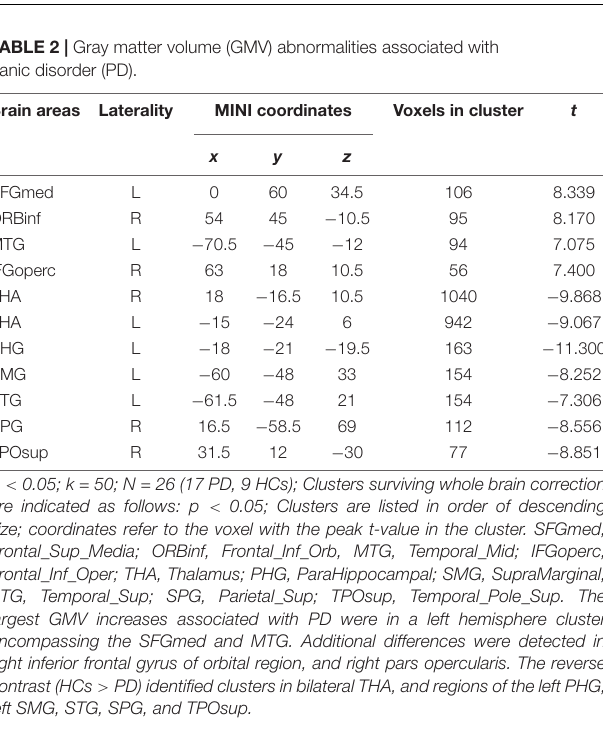
FIGURE 2 | Correlation between PDSS and GAD1 cg 12 methylation. Higher PDSSSUM scores were associated with relatively decreased cg171674146 GAD1 CPG7 island methylation ( r = –0.456, p = 0.025) in the total sample of 24 patients.